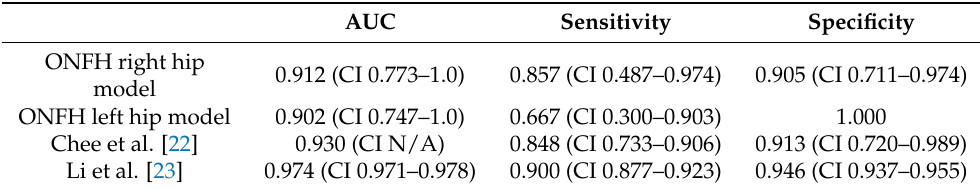
Table 3. Classification performance comparison with prior studies.